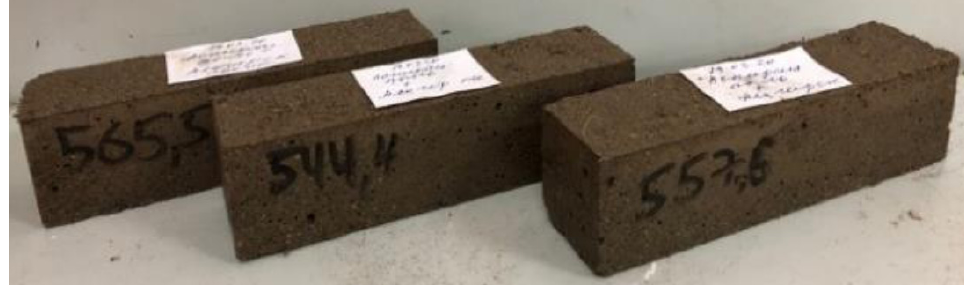
Figure 2. Sample beams with a size of 40 × 40 × 160 mm.